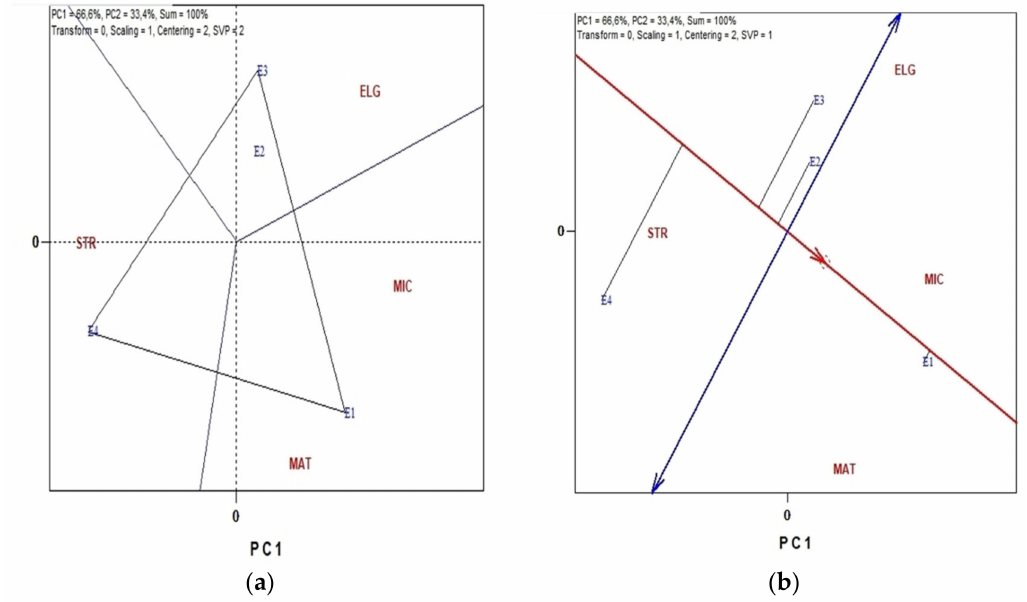
Figure 1. ( a , b ). Biplot analysis of micronaire (Mic), maturity index (Mat), strength (Str) and elongation (Elg), cotton quality measurements across four environments.